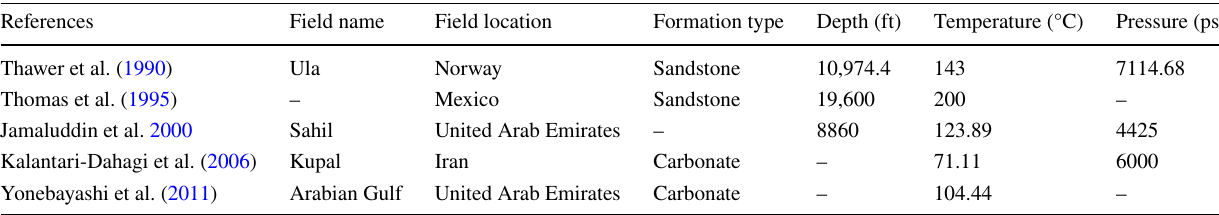
Table 8 Thermodynamic conditions for some field cases reporting asphaltene problems